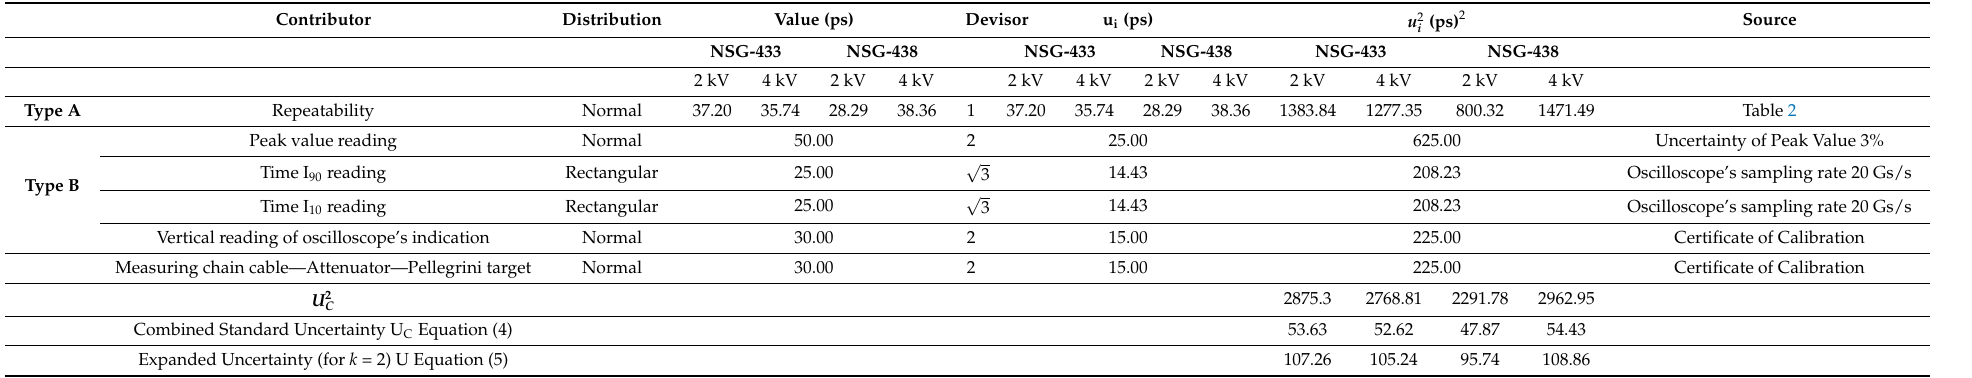
Table 4. Combined Standard Uncertainty for t r